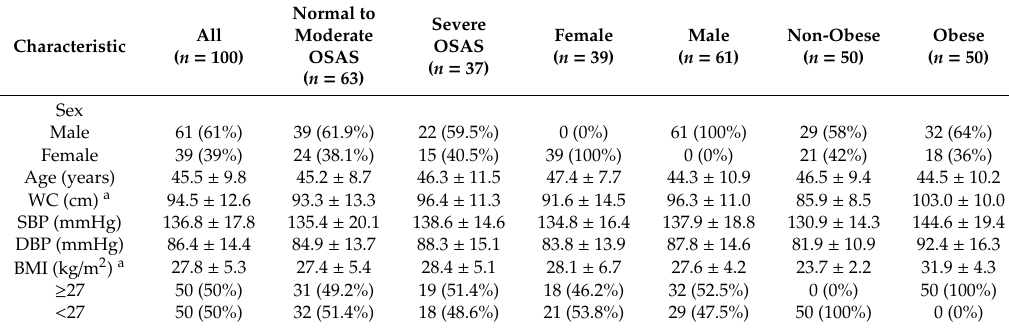
Table 1. Baseline demographics of the enrolled participants.